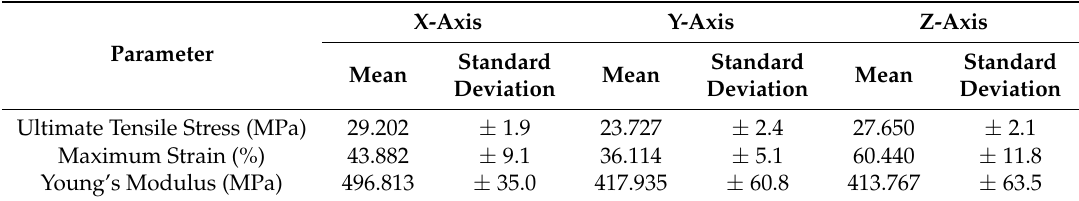
Table A2. D8520, D8530 combination thermal-mechanical properties.